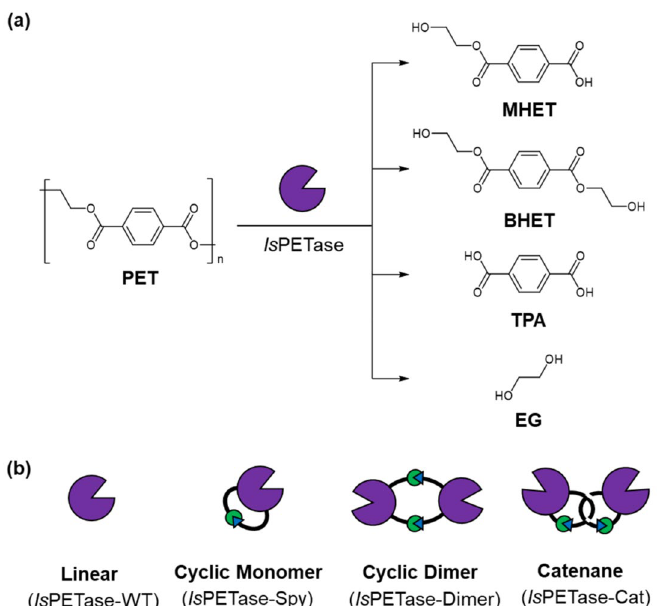
Figure 1. ( a ) The hydrolysis of PET catalyzed by Is PETase. ( b ) Cartoon representations of the linear and cyclic Is PETase